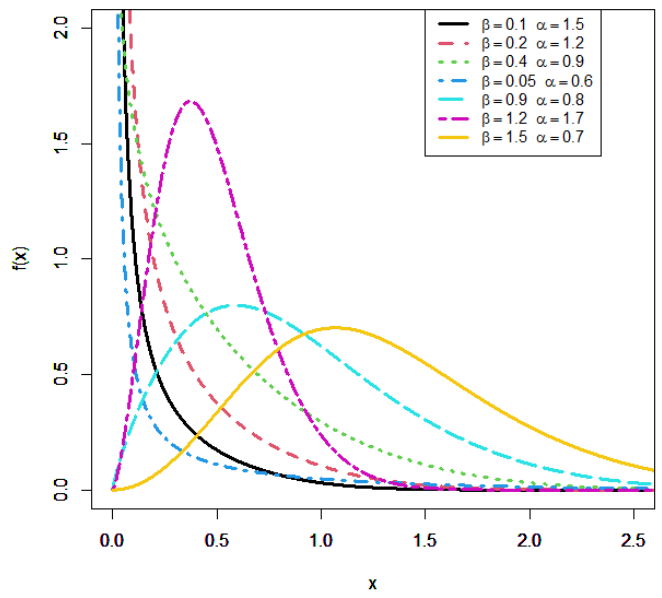
Figure 1. The pdf plots of the KMB X model.